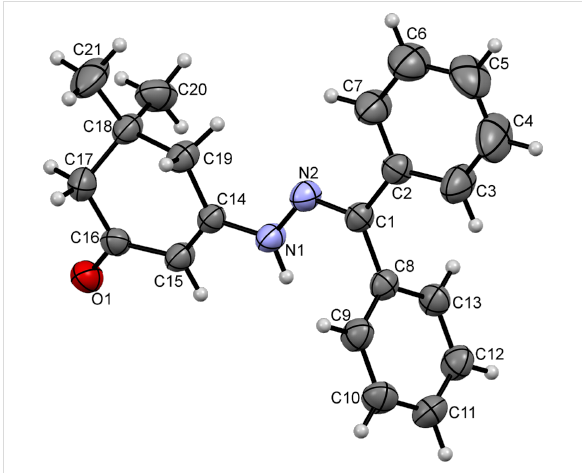
Figure 3: ORTEP drawing of compound 22a (CCDC 1546065) showing 50% probability amplitude displacement